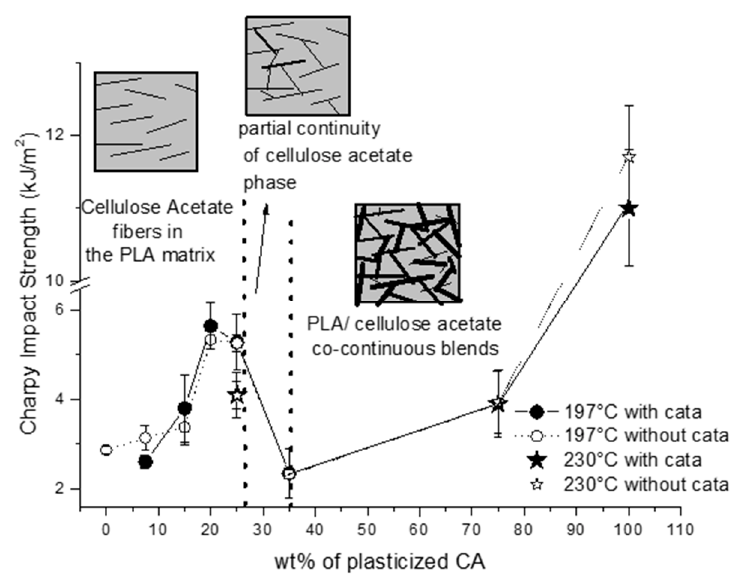
Figure 6. Charpy impact strength as a function of pCA content in the blends. The phase morphology as a function of pCA content in PLA/pCA blends is also indicated.